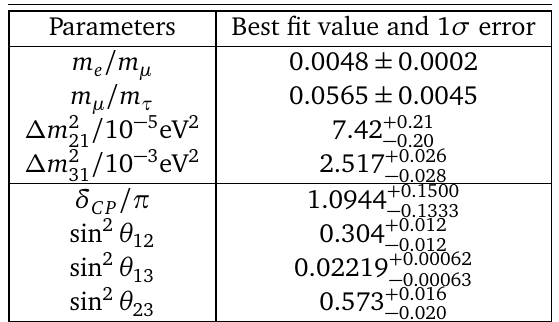
Table 2: The best fit values and the 1 σ ranges of the charged lepton mass ratios and the lepton mixing parameters. The charged lepton mass ratios averaged over tan β [ 5 ] are taken from ref. [ 82 ] , and we adopt the values of the lepton mixing parameters from NuFIT v5.0 with Super-Kamiokanda atmospheric data for normal ordering [ 83 ]